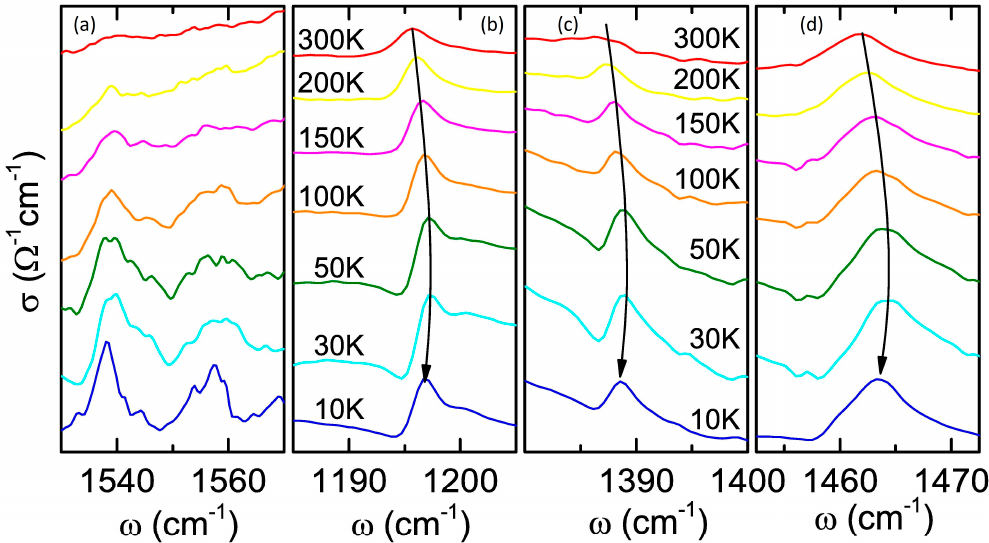
Figure 6. Temperature evolution of some molecular vibrations observed in (CNB-EDT-TTF) 4 ClO 4 : ( a ) for the modes ν 1 2 and ν 13 we observe a splitting, as the temperature drops below 30 K; ( b – d ) for most other modes, we observe a hardening when cooled down from room temperature, but below 30 K the modes exhibit a red shift. Note that the spectra are shifted with respect to each other for clarity.